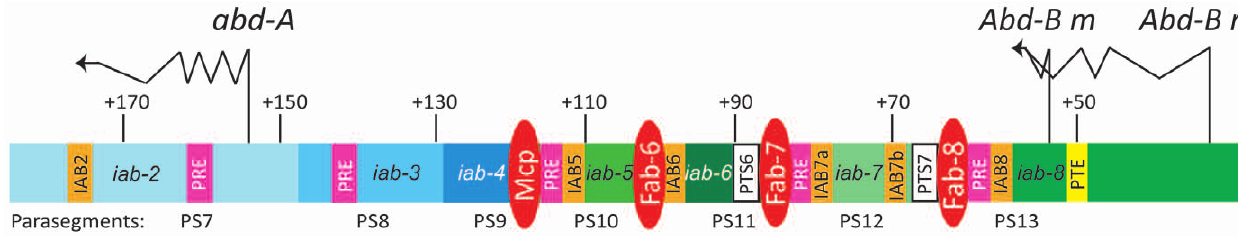
Figure 1. A network of interacting cis -regulatory modules control embryonic expression of abdominal-A and Abdominal-B in the Drosophila bithorax complex. The abd-A and Abd-B morphogenetic ( m ) and regulatory ( r ) transcripts are indicated by leftward arrows. The regulatory regions iab-2 , iab-3 and iab-4 (blue) interact with abd-A . The iab-5 , iab-6 , iab-7 and iab-8 regions (green) interact with Abd-B m . Each iab region is thought to contain at least one characterized enhancer (orange rectangles) capable of directing Hox gene expression in a specific embryonic parasegments (PS). The positions of the characterized Fab-6, Fab-7, Fab-8 and Mcp insulators (red ellipses), promoter targeting sequence (PTS) modules (white rectangles), promoter tethering element (PTE) (yellow rectangle) and polycomb response elements (PREs) (pink rectangles) are indicated. Numbers above line refer to kilobase positions in DNA sequence accession number: DM31961.